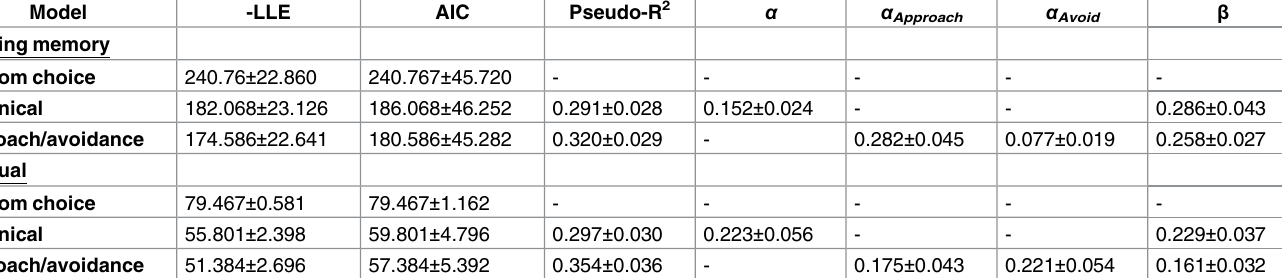
Table 2. Model fits. Mean ±